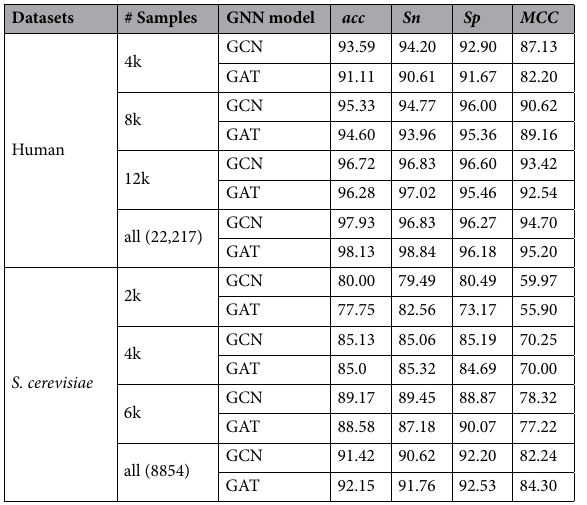
Table 8. Performance analysis of GNN variants using LSTM-based LM node features for different sample sizes of PPI datasets.